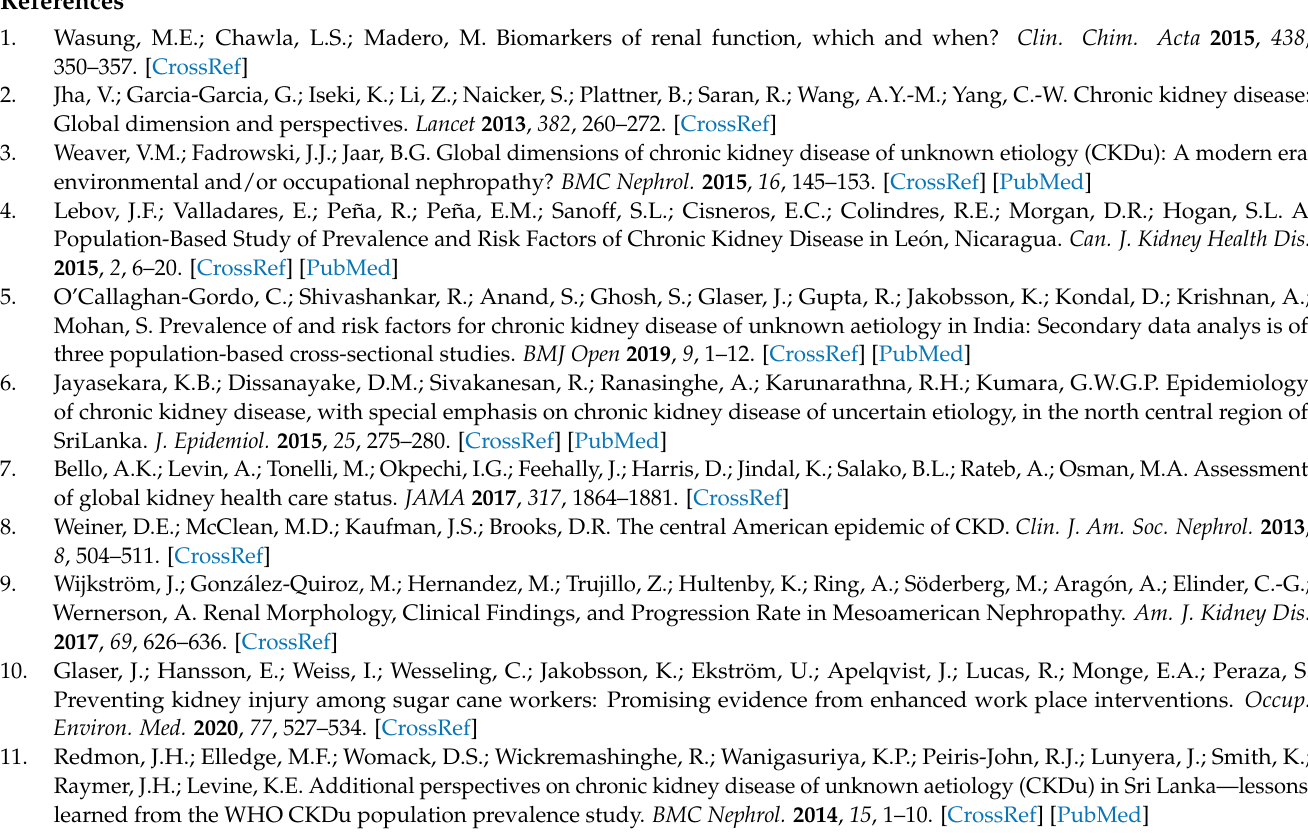
PKC-IM/6-CIPHD complexes, respectively. Figure S4: Variation of first three principal